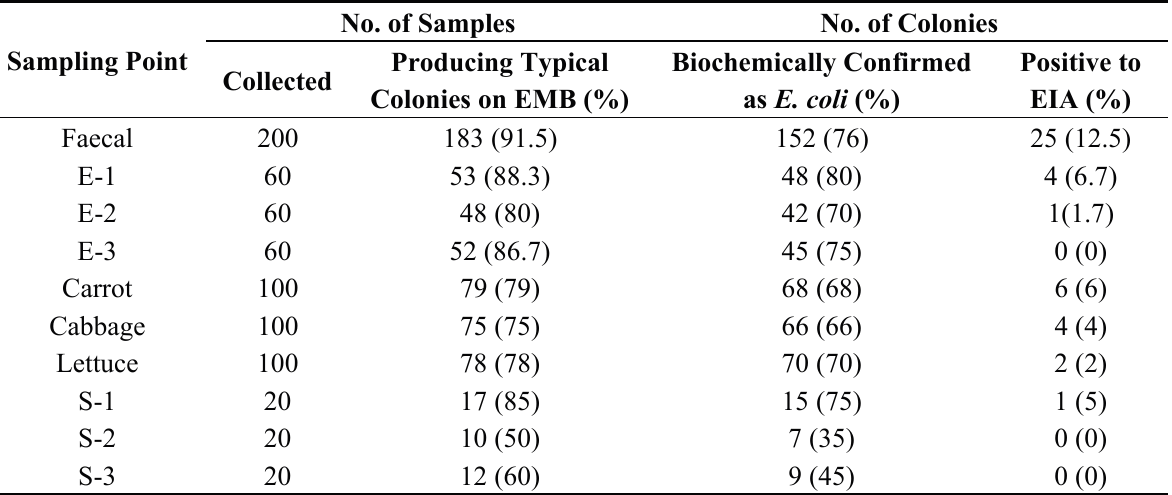
Table 1. Results of the E. coli isolation on EMB agar and Ridascreen Verotoxin EIA screening. Sampling